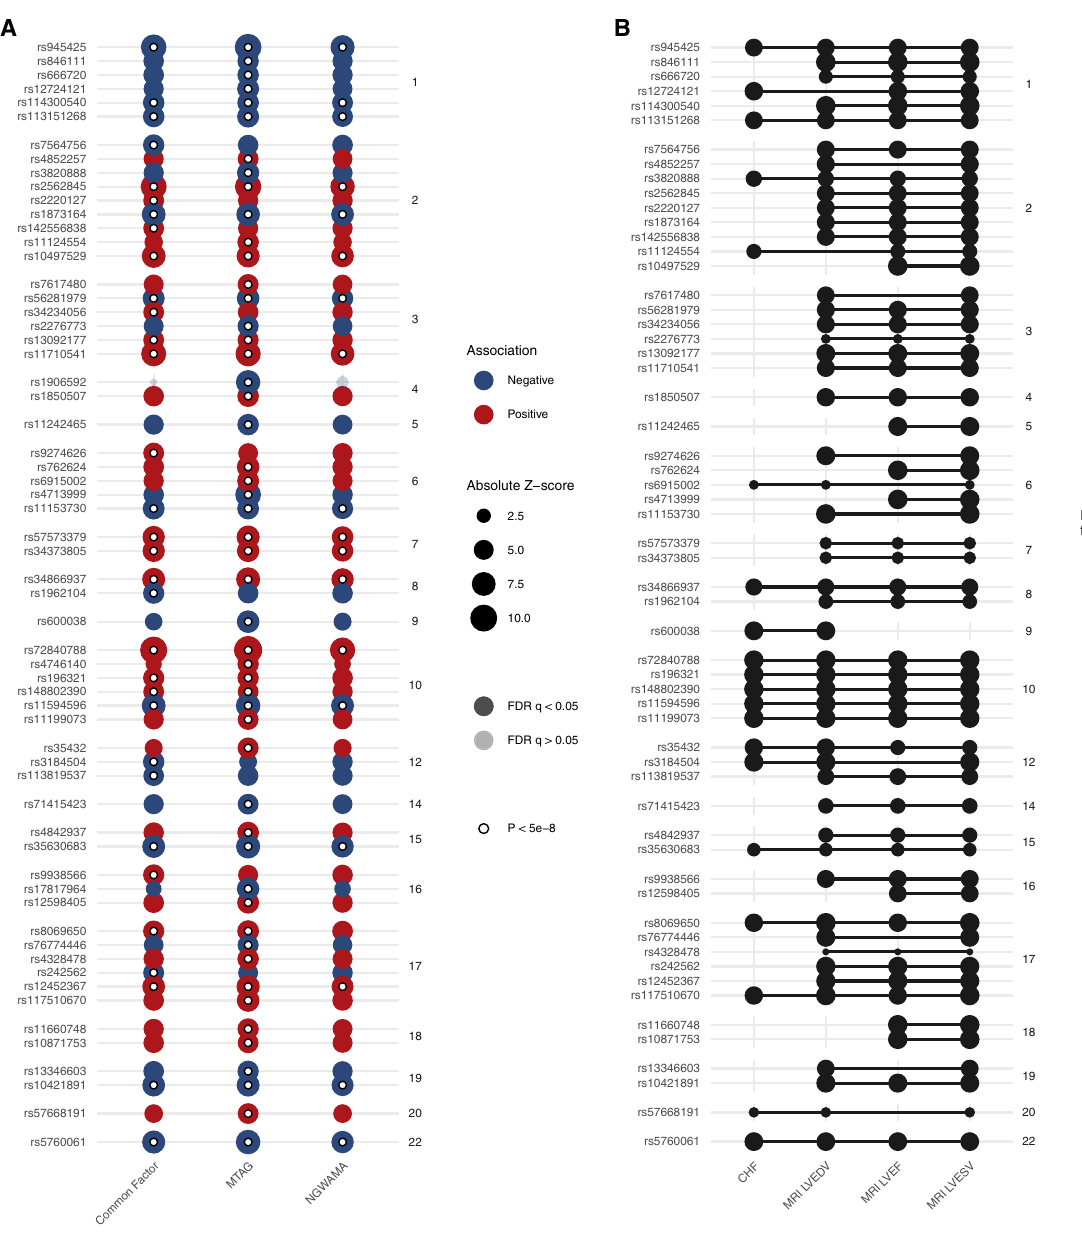
Variantsaregroupedbychromosome. B Resultsofmulti-traitcolocalization.The x - axisdenotesheart failureand cardiacimaging traits. The y -axisrepresents the lead variant at each independent locus identi fi ed in the multivariate GWAS. Lines con- nect groups of traits with evidence of colocalization at a given locus. The size of each point represents the posterior probability for colocalization. Evidence for colocalization was determined based on the default variant speci fi c regional and alignment priors ð P * R = P * A =0 : 5 Þ , with colocalization identi fi ed when P R P A ≥ 0 : 25. FDR false discovery